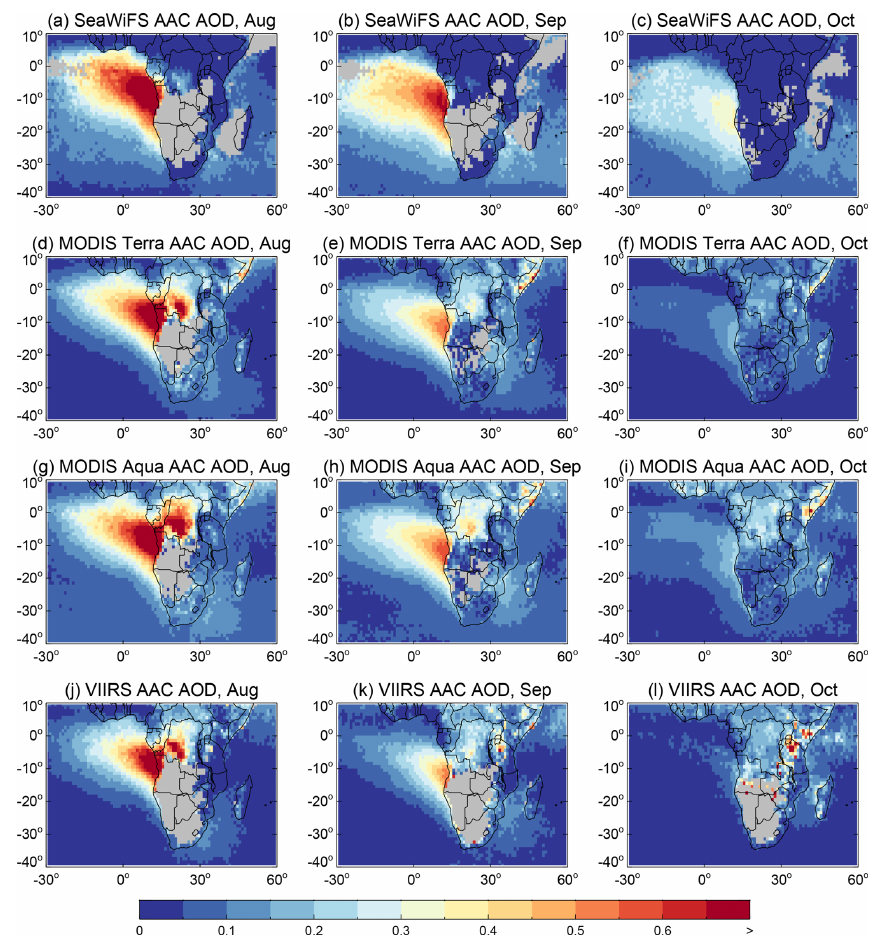
Figure 15. Multiannual monthly mean maps of AAC 550nm AOD constructed from the data records processed at the present time. Columns show (left–right) data for August, September, and October. Rows show (top–bottom) data for SeaWiFS (1997–2010), MODIS Terra (2000– 2017), MODIS Aqua (2002–2017), and VIIRS (2012–2017). Grid cells with fewer than 5 years contributing are shown in